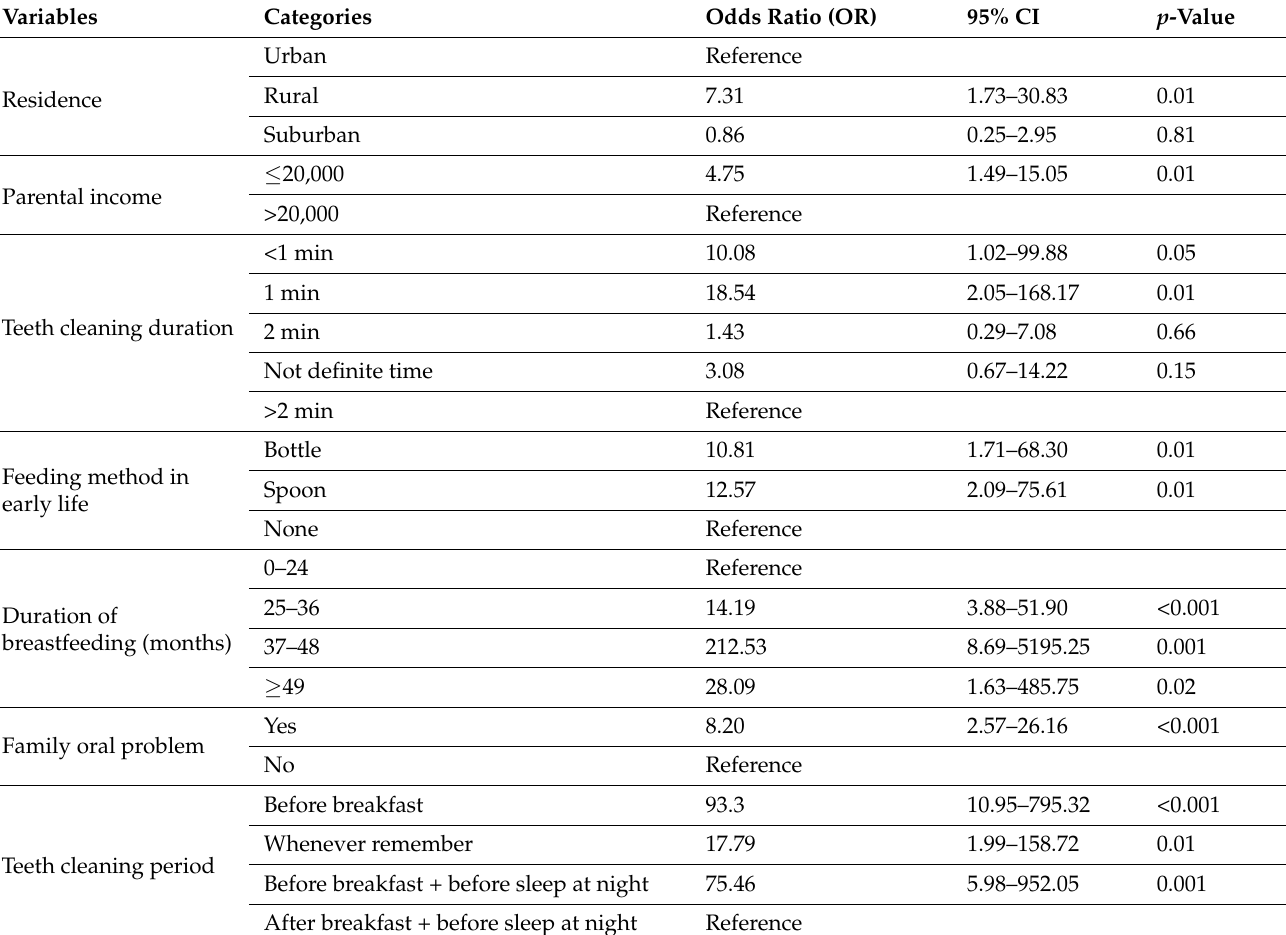
Table 6. Potential risk factors of dental caries in multiple logistic